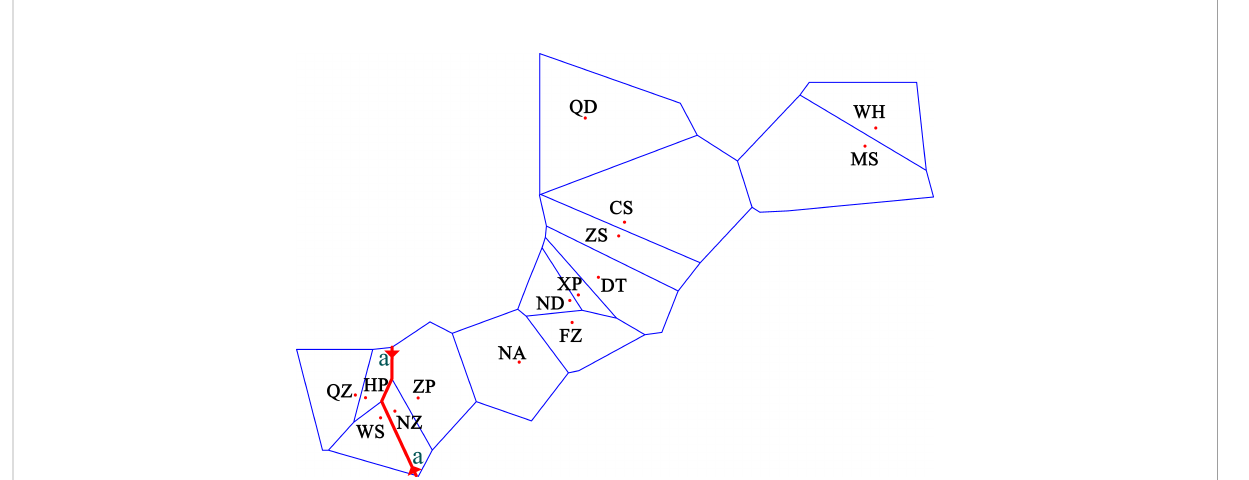
FIGURE 3 Results of the barrier analysis showing the spatial separation of populations of Sebastiscus marmoratus . Capital letters indicate populations. Lowercase letters indicate the order of the barrier found. Barriers are delimited by the small red line . QZ , Qingzhou; HP , Hepu; WS , Wushi; NZ ,